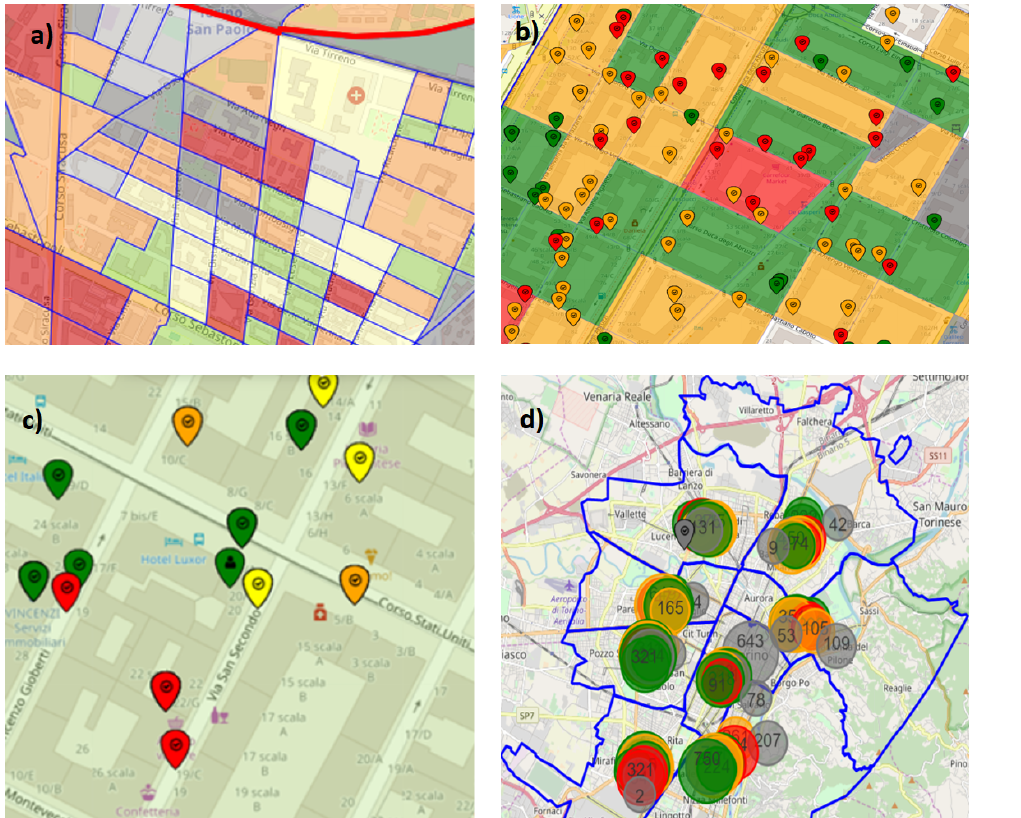
Figure 11. Examples of: choropleth map ( a ); choropleth and scatter map at neighborhood level ( b ); scatter map ( c ); and marker-cluster maps at city level ( d